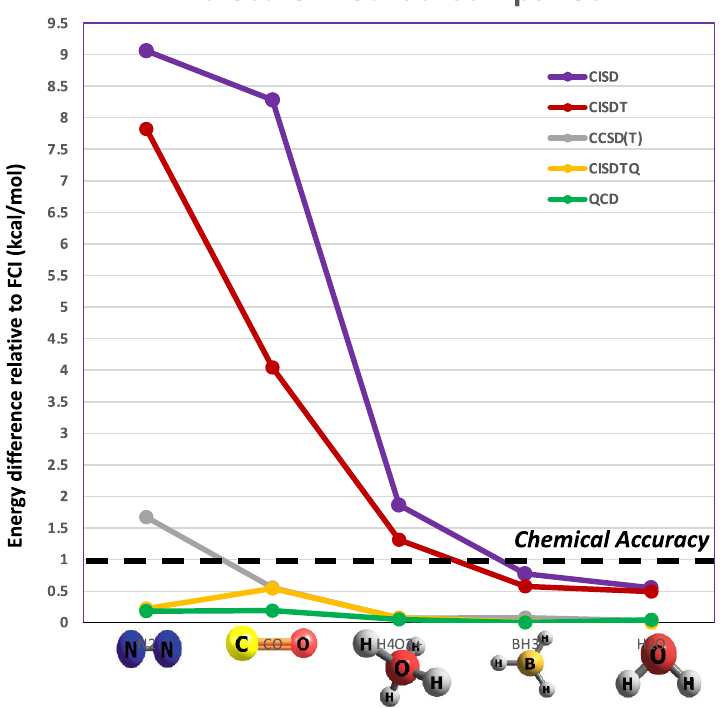
Figure 4. Comparison of Quantum Community Detection with current methods. Results for CISD, CISDT, CCSD(T), CISDTQ, and our Quantum Community Detection (QCD) relative to FCI are shown for five molecules, N 2 , CO, H 4 O 2+ , BH 3 , and H 2 O. CISD (violet), CISDT (red) and CCSD(T) (gray) produced energy differences greater than chemical accuracy for one or more molecules. For these five molecules we can see